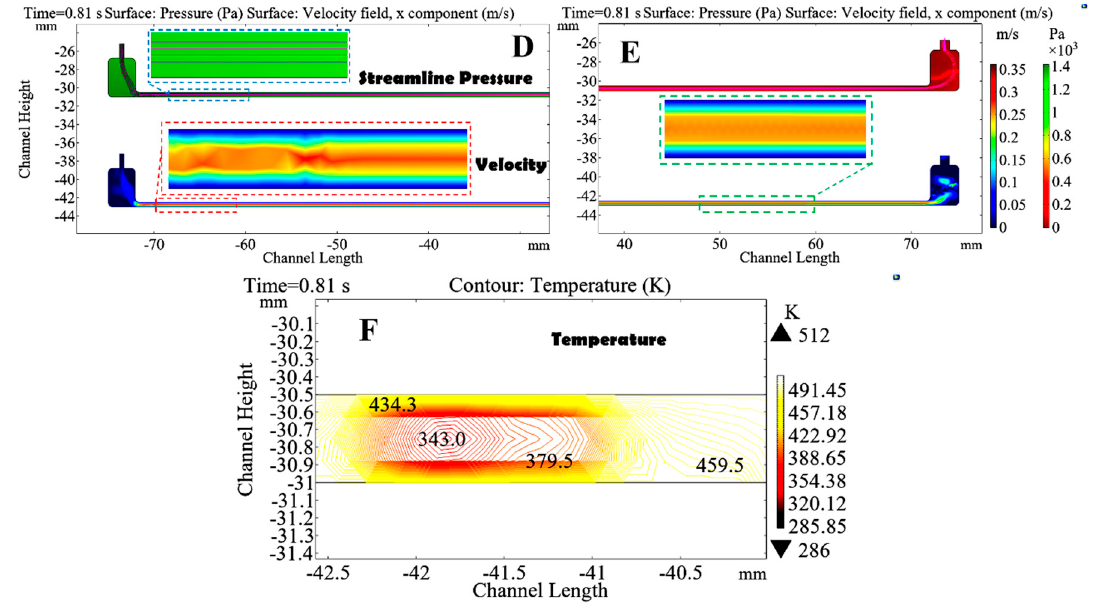
Figure 10. The fundamental variables of two-phase flow in the channel in phase field with the increasing and decreasing temperature boundary. Velocity and pressure: ( D ) channel inlet, ( E ) channel outlet and temperature contours: ( F ) random section along the horizontal channel.